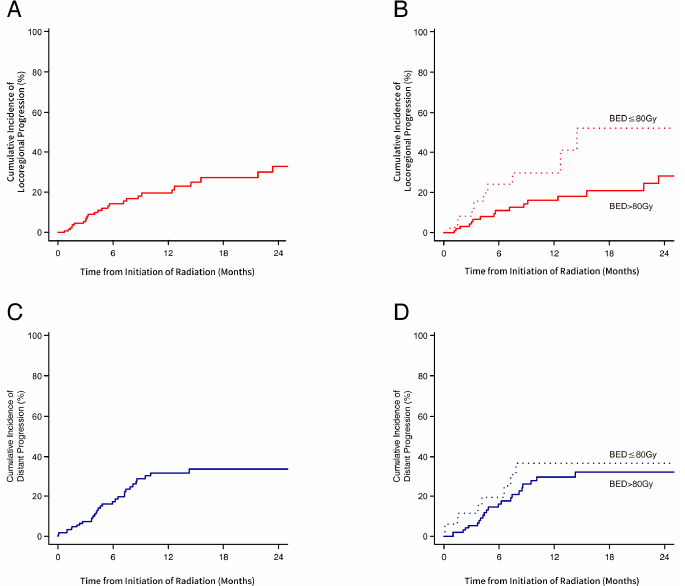
Figure 5. Cumulative incidence of disease progression. Cumulative incidence of locoregional progression ( A ); cumulative incidence of locoregional progression between BED dose groups ( B ); cumulative incidence of distant progression ( C ); cumulative incidence of distant progression between BED dose groups ( D